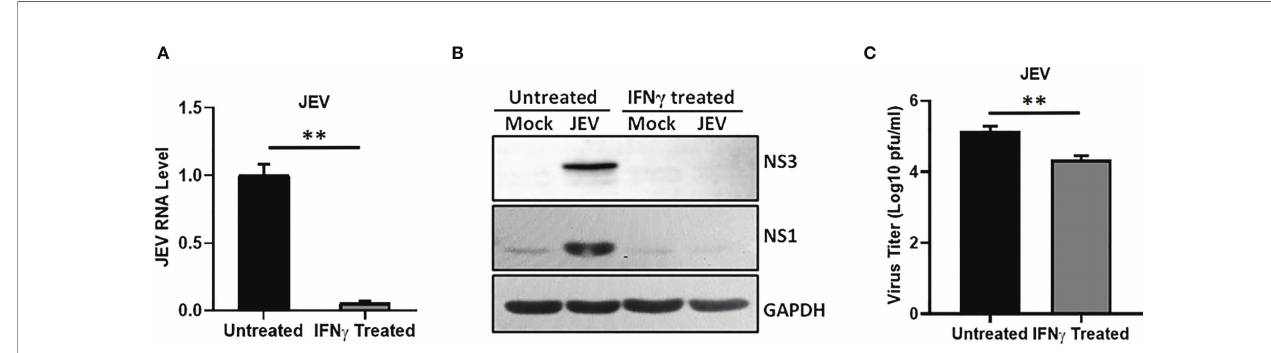
FIGURE 2 | IFN g restricts JEV replication. HeLa cells were mock or IFN g (12 ng/ml) treated for 12 h followed by JEV infection at 1 MOI. At 24 hpi, cells were harvested for RNA isolation and cell lysate preparation and supernatant was collected to quantitate virus titer. (A) Relative JEV RNA level was analyzed by qRT- PCR, (B) Western blots showing the levels of JEV-NS3, JEV-NS1 and GAPDH (loading control). (C) Bar graph showing the virus titers determined by plaque assays. Data presented is mean ± SD of values obtained from 3 independent experiments. Student t -test was used to calculate P values. ** P < 0.01.